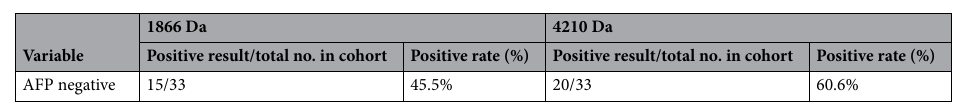
Table 3. Rates of 1866 Da and 4210 Da in AFP-negative patients with HCC (HCC vs. CHB). AFP negative < 7.00 ng/ml; Positive result for 1866 Da < 124.00 mV; Positive result for 4210 Da < 233.50 mV.